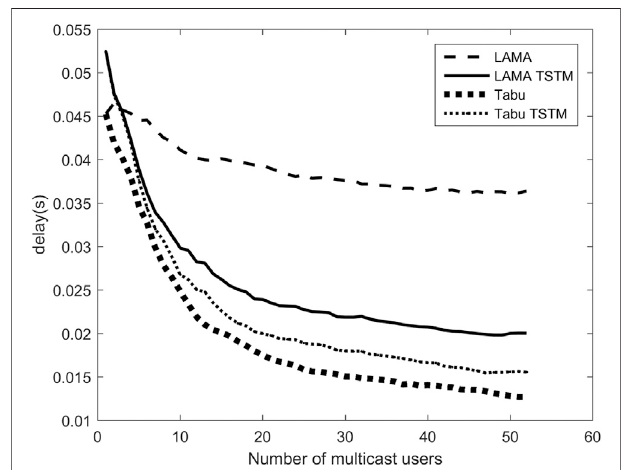
FIGURE 10 | The probability distribution of the load factor β .